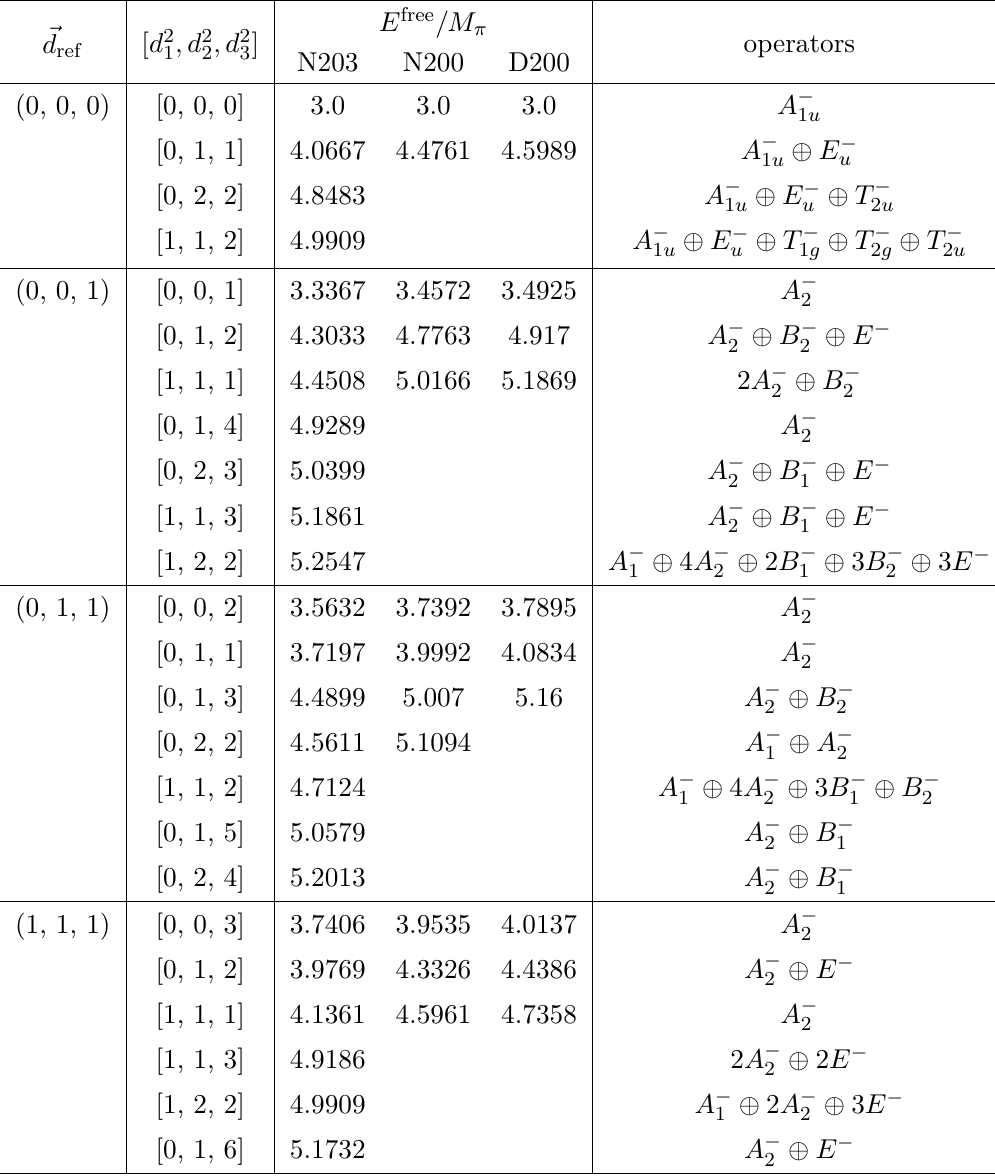
Table 21. Three-pion operators with ~d 2 ≤ 3 used in this study. Each row specifies all linearly- ref independent operators corresponding to a particular free energy-level. Ensembles with a missing value for the energy of the free level E free did not use those operators. For each set of momenta that are equivalent up to allowed rotations, one representative integer momentum specifying the total momentum of the operator ~P = (2 π/L ) ~d ref is given. The integer momentum squared of the individual single particles in each operator is given by d 2 i